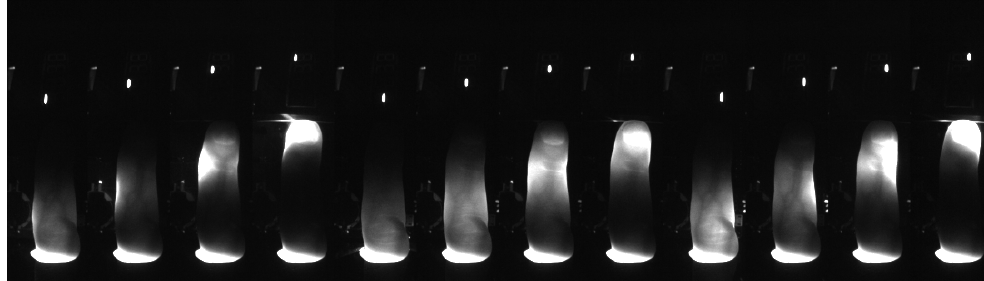
Figure 5. Sample combined series of extracted images.